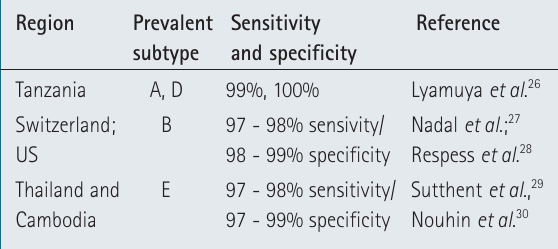
TABLE II. SUMMARY OF PERFORMANCE OF